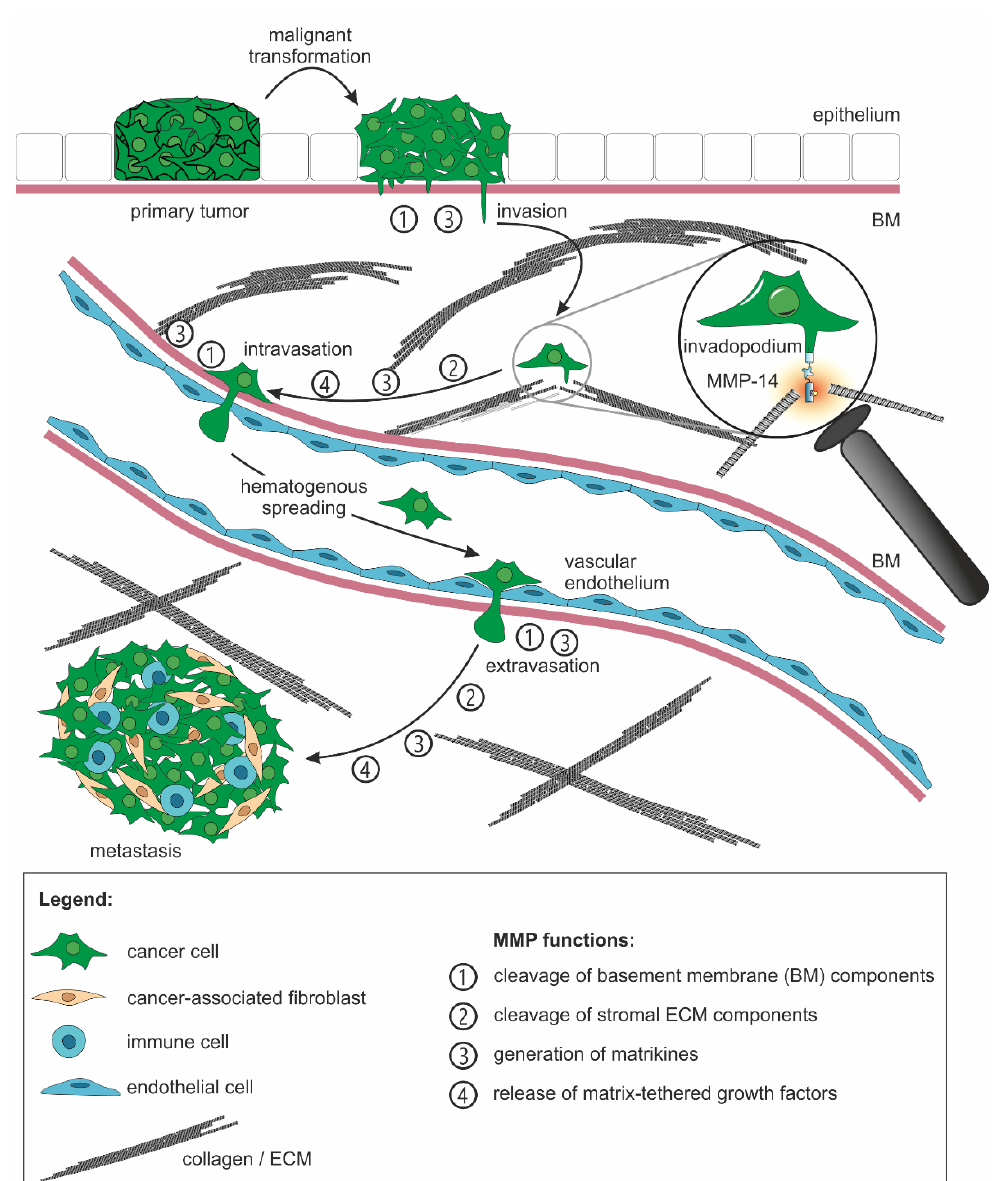
Figure 1. Proteolysis by matrix-metalloproteinases is crucial in every step of the metastatic cascade. A malignant tumor arises from a benign one by the acquisition of a basement membrane (BM)- breaching phenotype. To facilitate cancer cell dissemination from a primary tumor, MMPs on cancer cells cleave cell–cell adhesion molecules and are responsible for breaching the BM and invasion of the subjacent stromal ECM. They are also involved in intra-and extravasation by helping to break through the endothelial BM and the endothelium of blood vessels. Additionally, they activate ECM- tethered growth factors and release matrikines from ECM components. As the only membrane- bound collagenase, MMP-14 in invadopodia of cancer cells is of outstanding importance in the en- tire metastatic cascade.